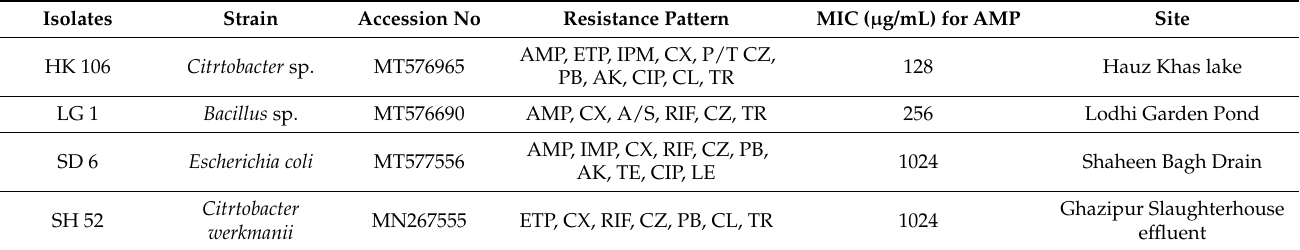
Table 4. Resistance pattern of environmental isolates.